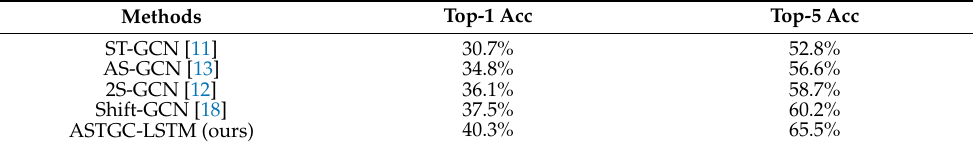
Table 1. Performance comparison using kinetics with the current state-of-the-art methods.